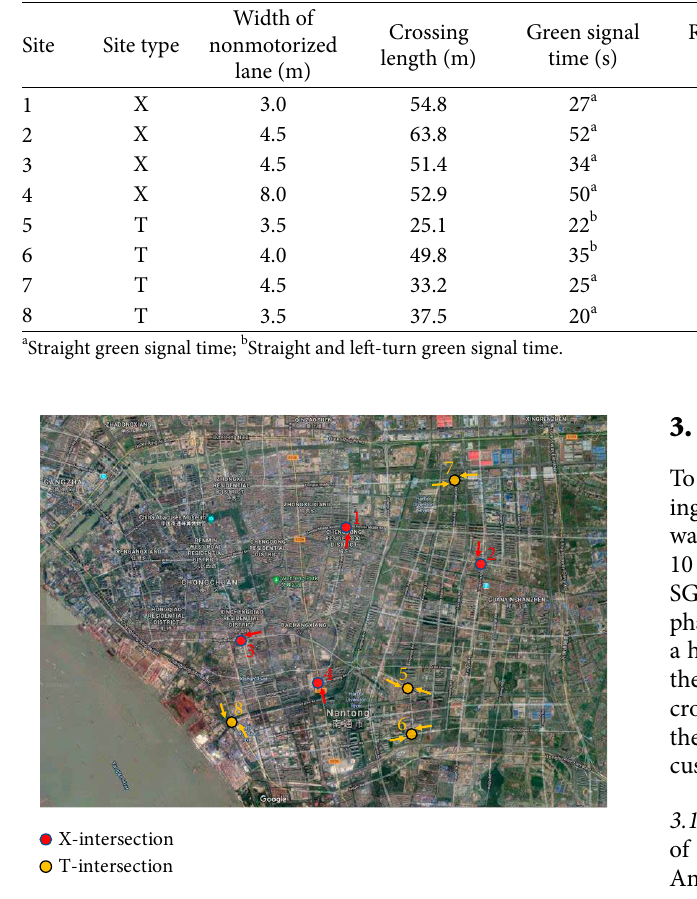
Figure 2: Field data collection